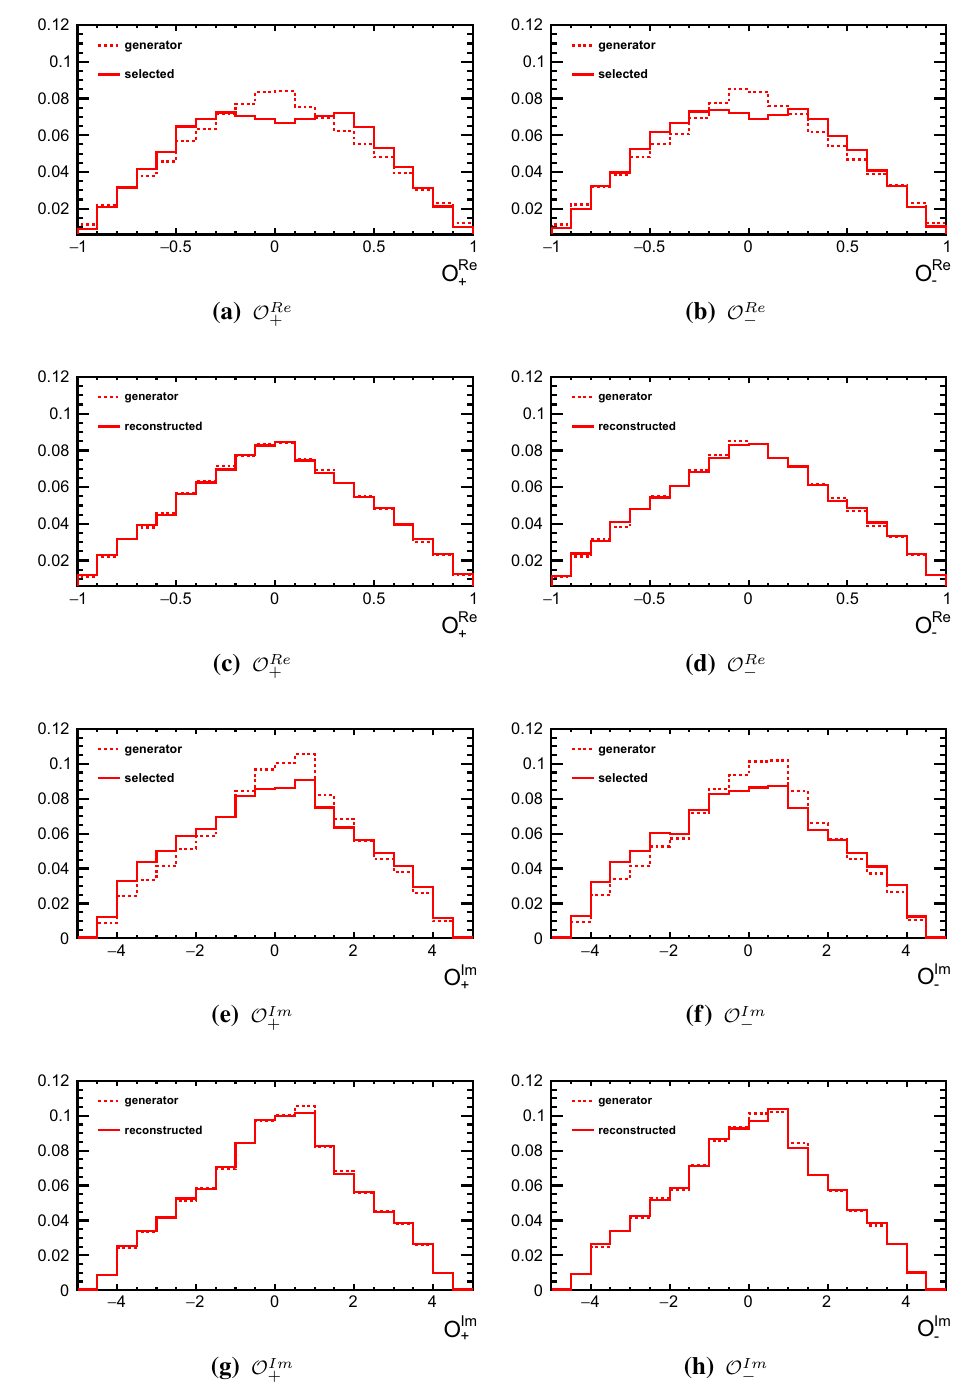
√ Fig. 5 The CP-odd observables O Re , Im ± for CLIC at s = 3 TeV. resolution on O Re ± are shown. Panels c and d represent the effect of the The two distributions correspond to the reconstructed (solid) and true selection on O Im ± , g and h the impact of the angular and energy resolu- e + e + (dashed)distributionsfor e − polarization.Theresultsfor e − polar- tion. All histograms are normalized to unit area. The O Im ± distribution L R 0 0 ization are similar. Panels a and b represent the effect of the polar angle is truncated to the interval [ − 5, selectionon O Re ± . In panels c and d the impactof the angular and energy